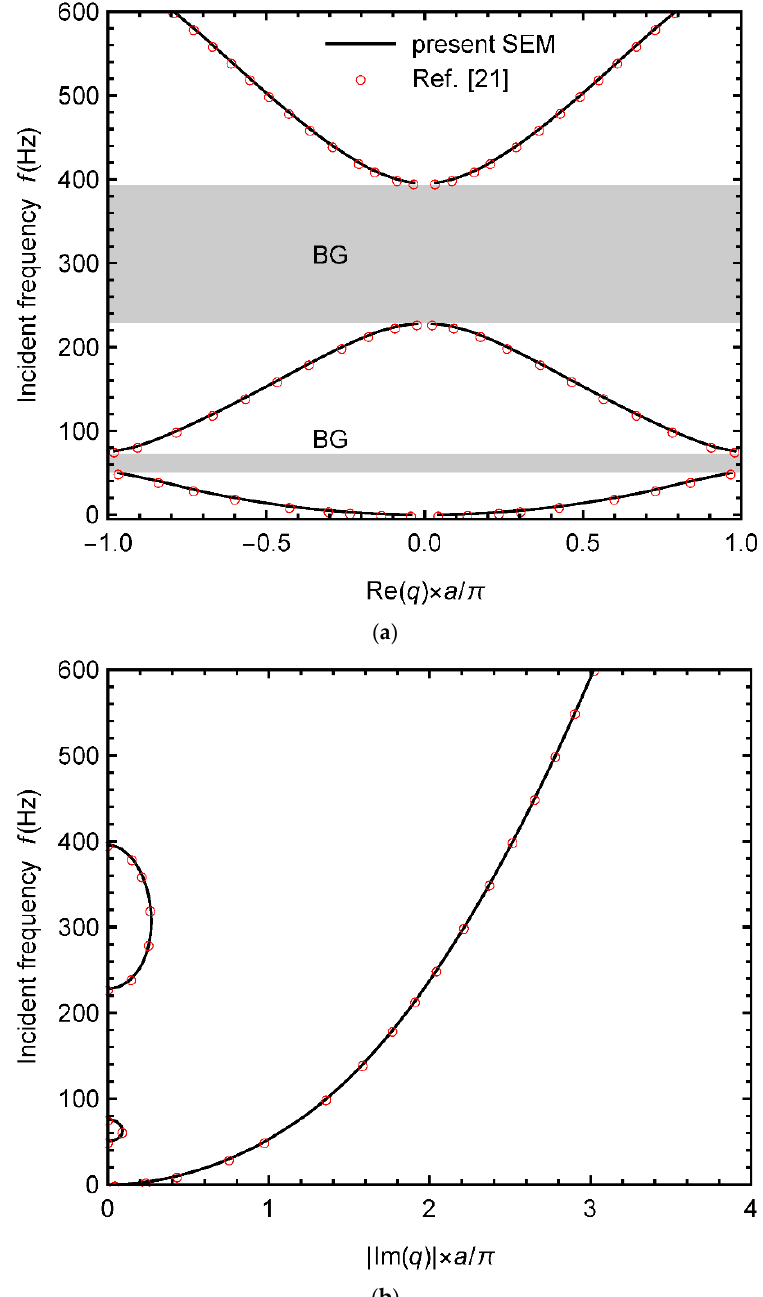
Figure 2. Band structure of a static-water-filled periodic pipe: ( a ) real part of the wave vector, ( b ) absolute imaginary part of the wave vector.